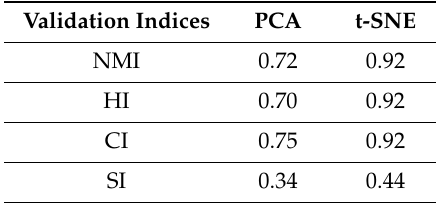
Table 1. Average values of clustering indices.